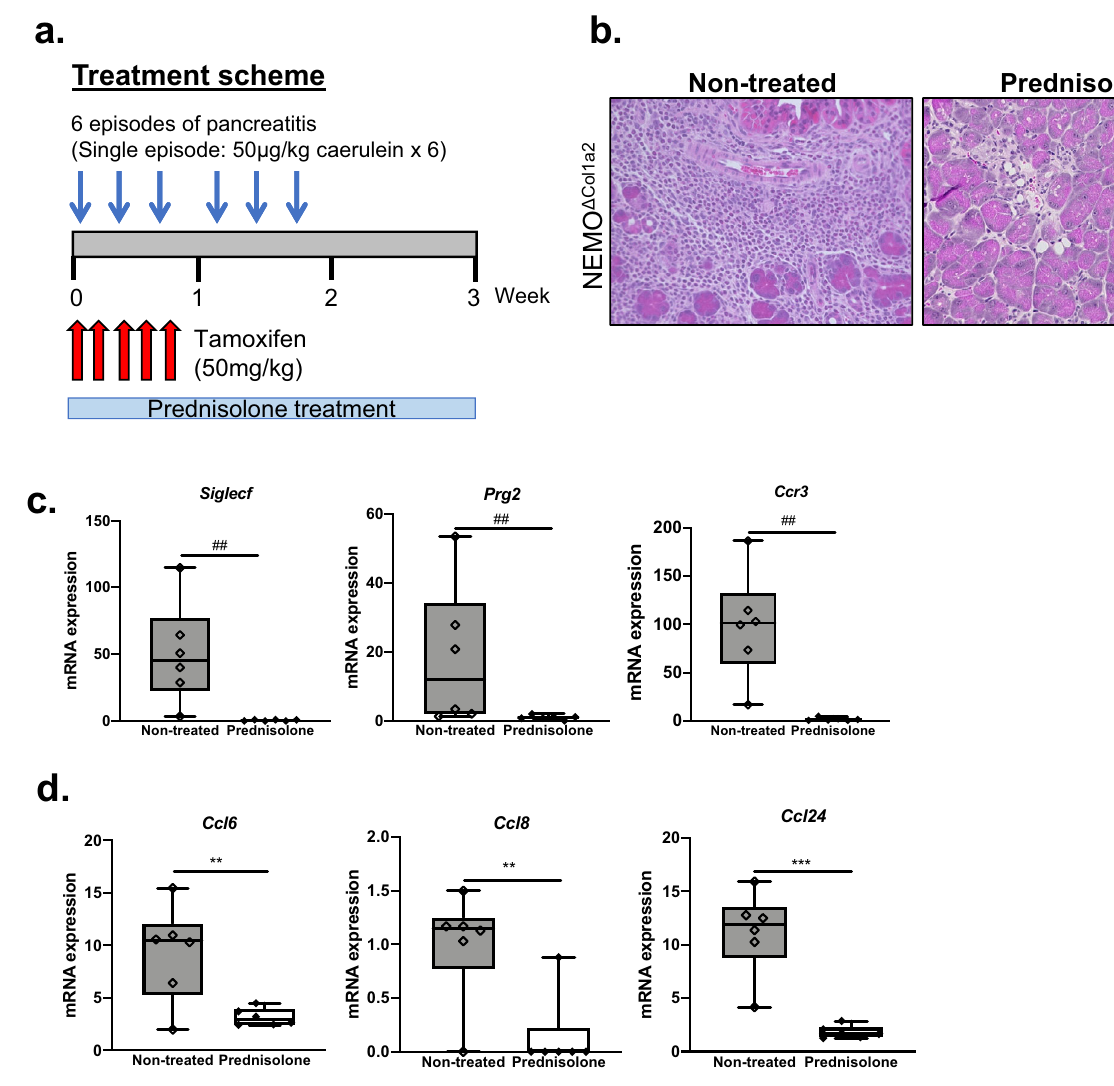
Fig. 9 Treatment of prednisolone attenuates the AIP phenotype in NEMO Δ Col1a2 mice. a Scheme of prednisolone treatment. b Pancreatic histology of NEMO Δ Col1a2 mice with or without prednisolone treatment. Scale bar: 100 µ m. c , d Expression of eosinophil markers and chemokines assessed by qPCR ( n = 6). Whiskers: Min to Max. T -test (two-tailed): ** p < 0.01; *** p < 0.001. Mann – Whitney (two-tailed): ## p < 0.01. The n number represents biological